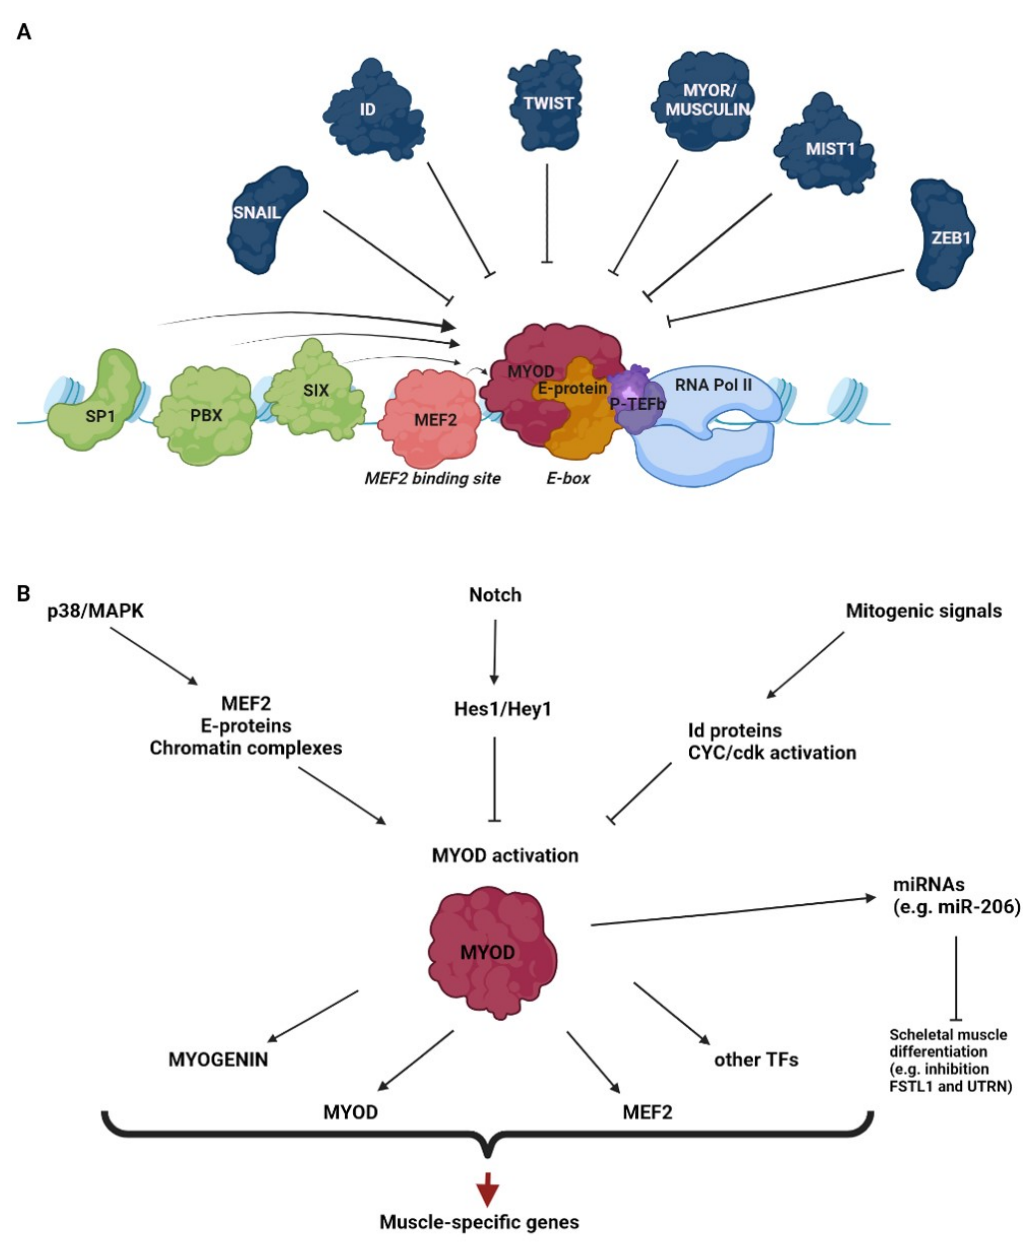
Figure 1. Regulation of MyoD transcriptional activity. The drawings outline some of the main co-factors ( A ) and signaling pathways ( B ) that promote or inhibit the transcriptional activation by MyoD.